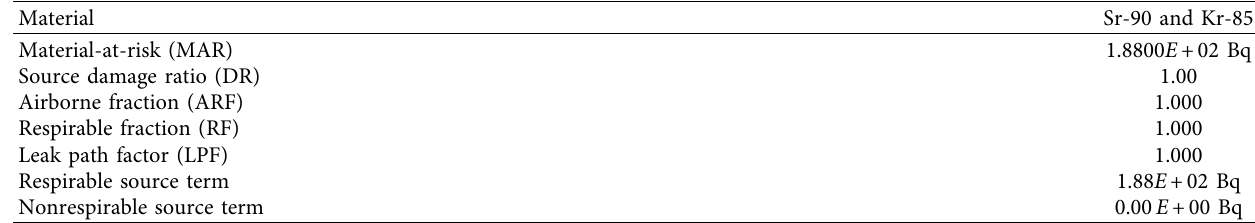
Table 3: Summary of hypothetical assumption applied.